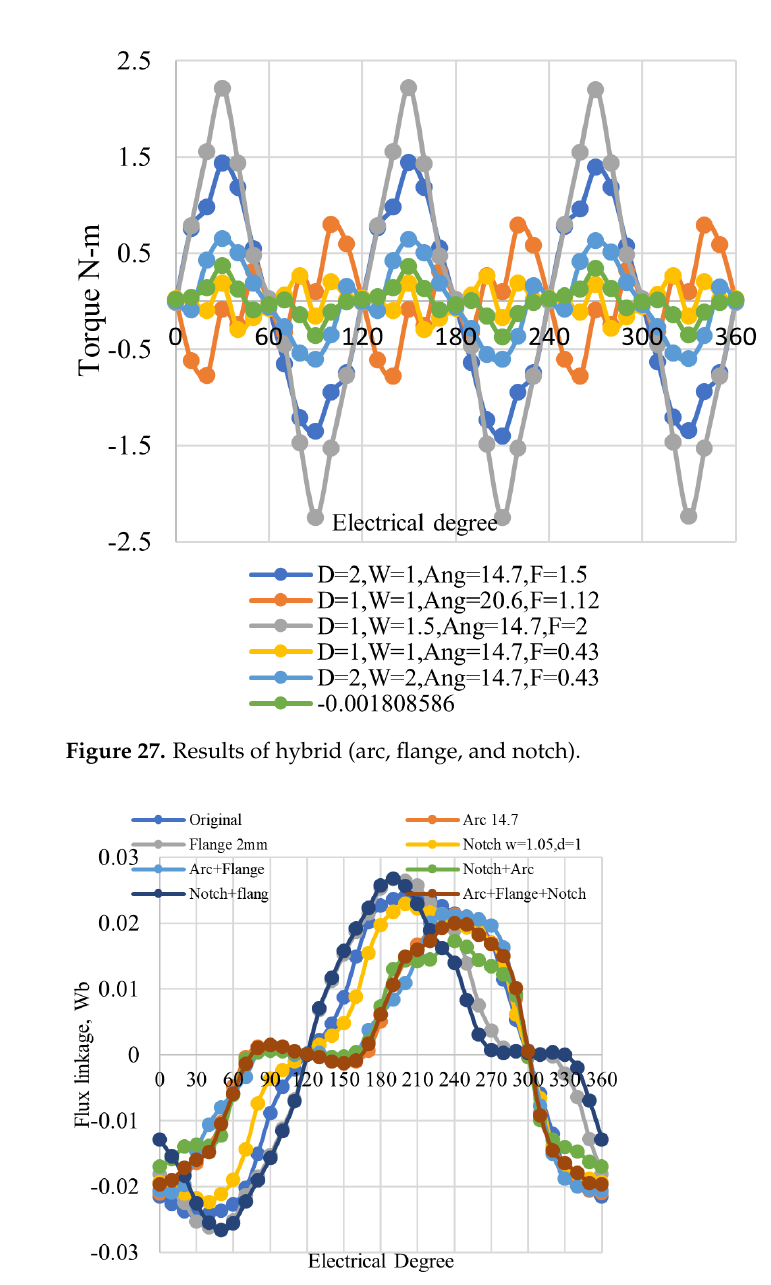
Figure 28. Flux linkage of all